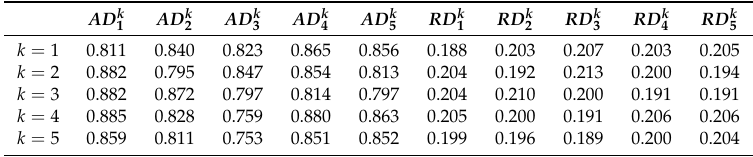
Table 2. The averaging and relative consistency degree among experts to each